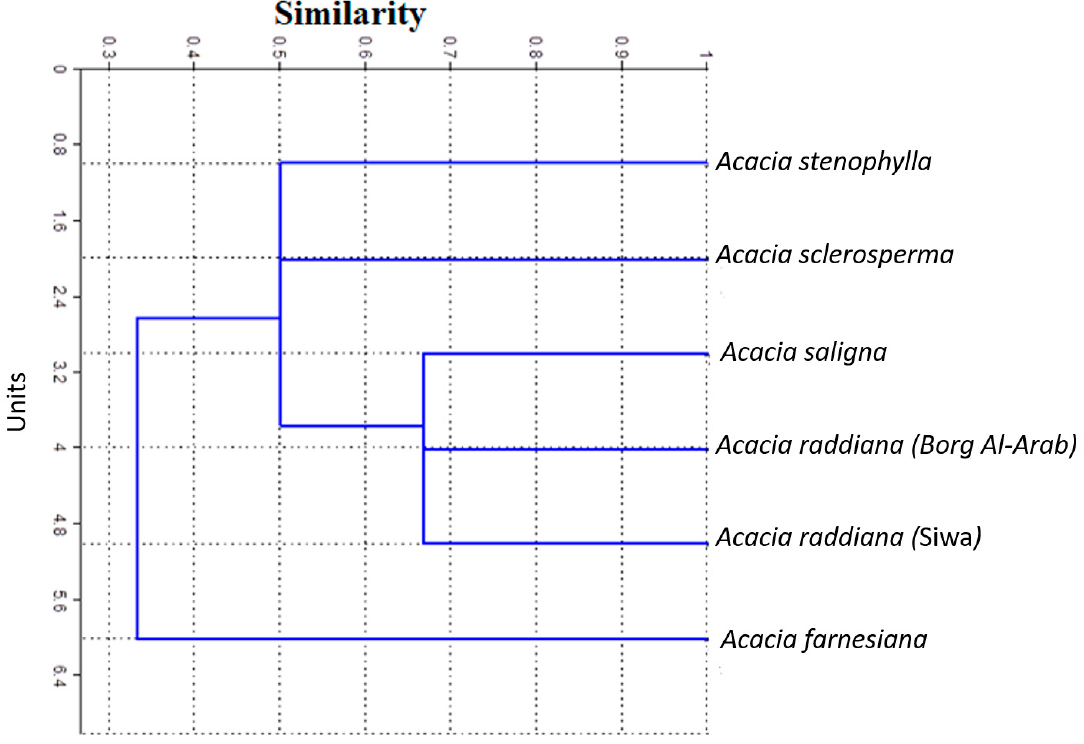
Figure 4. Similarity and genetic distance of Acacia spp . Under the certain study.